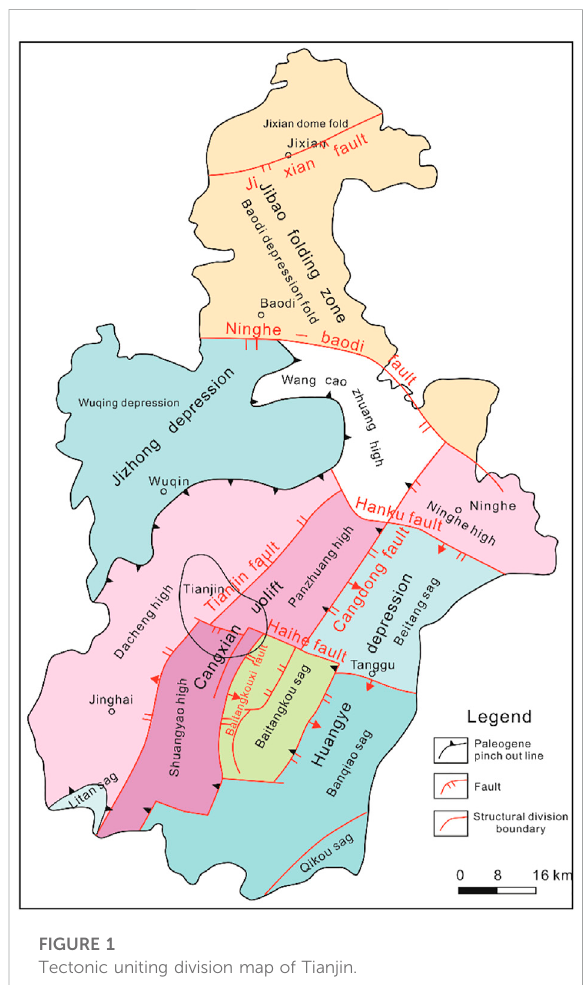
FIGURE 1 Tectonic uniting division map of Tianjin.